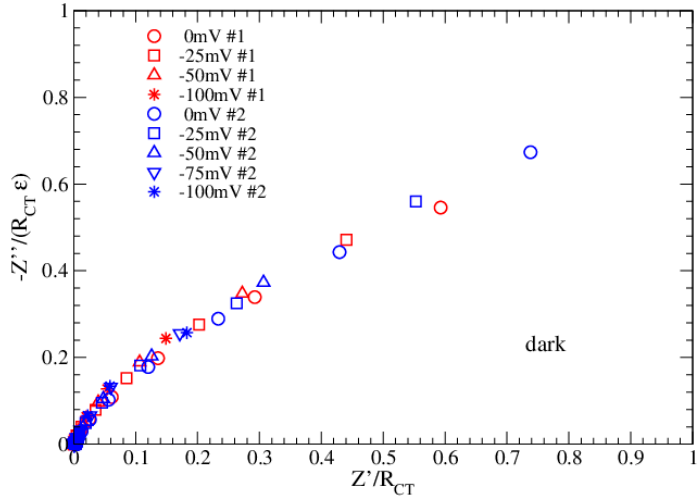
Figure 6. Normalized Nyquist plots in dark for Datasets 1 and 2.